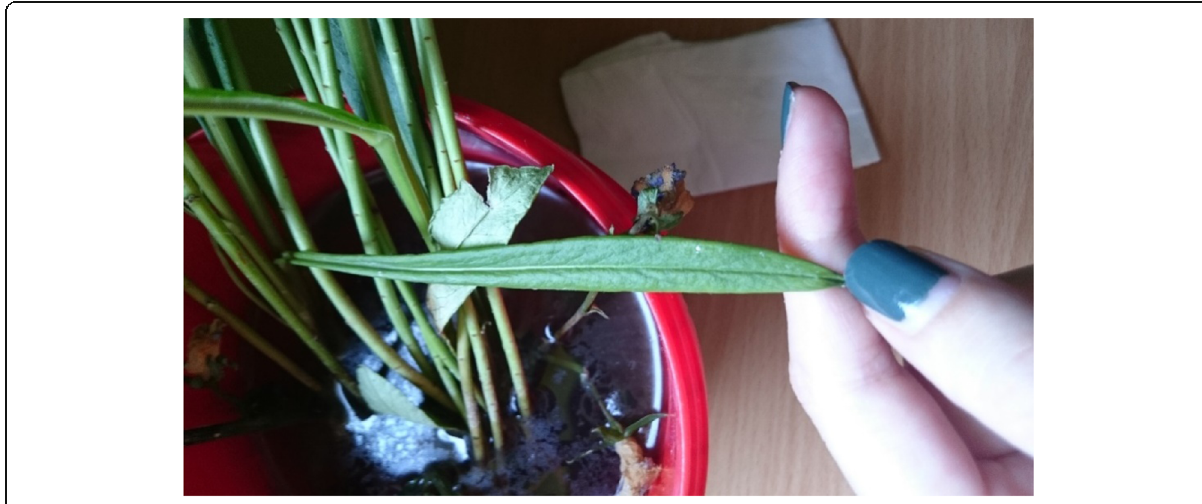
Fig. 7 Leaf of selected plant species: Bell flower ( Campanula persicifolia